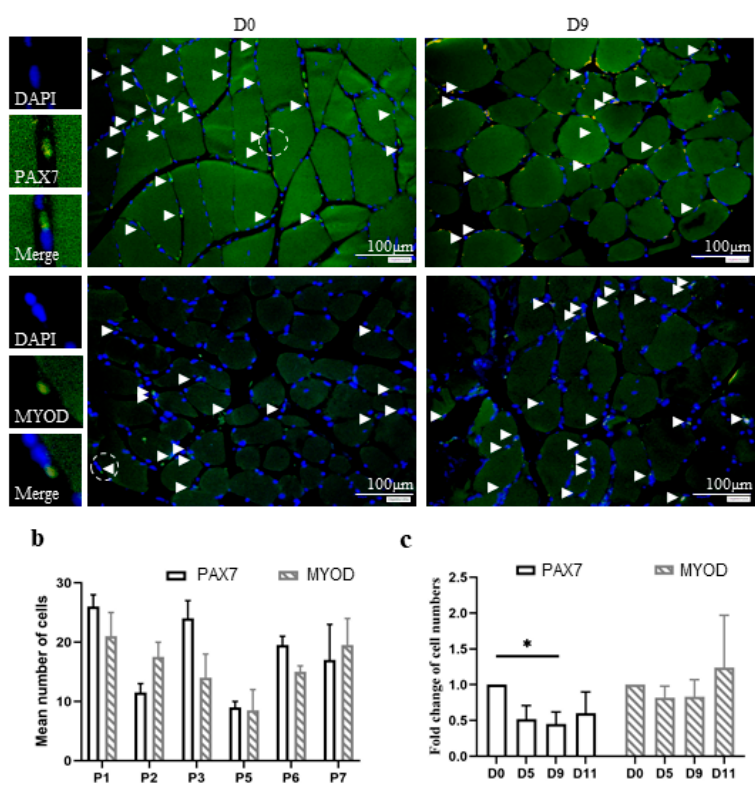
Figure 3. Stem cells in human skeletal muscle tissue were maintained in vitro for 11 days. Skeletal muscle tissue sections were analyzed for the presence of satellite cells (PAX7-positive) or myoblasts (MYOD-positive) using immunofluorescence and DAPI staining. ( a ) The images are representative of all sections from 6 participants before (D0) or after 5 (D5), 9 (D9), or 11 (D11) days of maintenance in vitro. Sections from a single participant at D0 and D9 are presented and labeled at the top of each image. White arrowheads indicate the positive cells. The white scale bars represent 100 µm. Left panels present fluorescence images at higher magnification of a single satellite cell or myoblast (green), DAPI (blue), and merged signals, as depicted. The mean numbers of positive cells from two randomly selected fields of 0.24 mm 2 within cross-sectional areas of muscle fibers were obtained. ( b ) The diagram shows the mean numbers of PAX7-positive satellite cells (white bars) and MYOD- positive myoblasts (hatched bars) in 0.24 mm 2 of muscle fibers from individual participants as designated at D0 (Supplementary Table S3). ( c ) The diagram shows the mean fold change, which was determined by normalizing the number of PAX7-positive (white bars) or MYOD-positive (hatched bars) cells in the samples from each participant at D0, D5, D9, and D11 to that at D0. Thus, D0 was set to one for every single participant and for the mean change at D0 (Supplementary Table S4). p ≤ 0.01 (*). As expected, the individual ratios of satellite cells to myoblasts were not significantly different. We determined the relative fold changes in satellite cell and myoblast numbers by comparing the numbers with those at D0 (Figure 3c). Thus, the relative change at D0 was set to one. The results indicated that the number of satellite cells successively decreased over 11 days of maintenance in vitro. However, the number of myoblasts was slightly increased. Interestingly, the sum of satellite cells and myoblasts indicated nearly